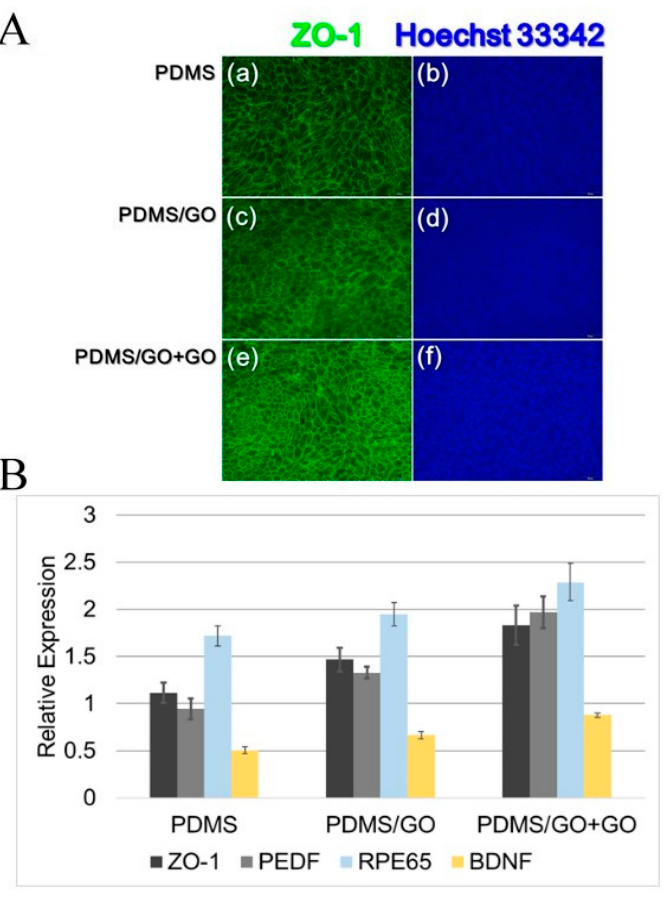
Figure 9. Examination of the expression of ZO ‐ 1 protein and various RPE ‐ related genes in hiPSC ‐ RPEs cultivated on PDMS, PDMS/GO, and PDMS/GO + GO. ( A ) Expression of tight junction protein ZO ‐ 1 in hiPSC ‐ RPEs cultivated on PDMS membrane with different GO modifications. Immunofluorescence staining was performed to evaluate the ZO ‐ 1 expression in hiPSC ‐ RPEs cultivated onto ( a ) pure PDMS, ( c ) PDMS/GO, and ( e ) PDMS/GO + GO. Corresponding Hoechst counterstaining for each treatment is shown ( b,d,f ). Regular hiPSC ‐ RPE morphology was observed among all conditions, while the PDMS/GO + GO group showed the highest ZO ‐ 1 expression. ( B ) Quantitative RT ‐ PCR results revealing the higher expression of RPE ‐ related genes, including ZO ‐ 1, PEDF, RPE65, and BDNF, in hiPSC ‐ RPEs cultivated with PDMS with GO modifications and coating.